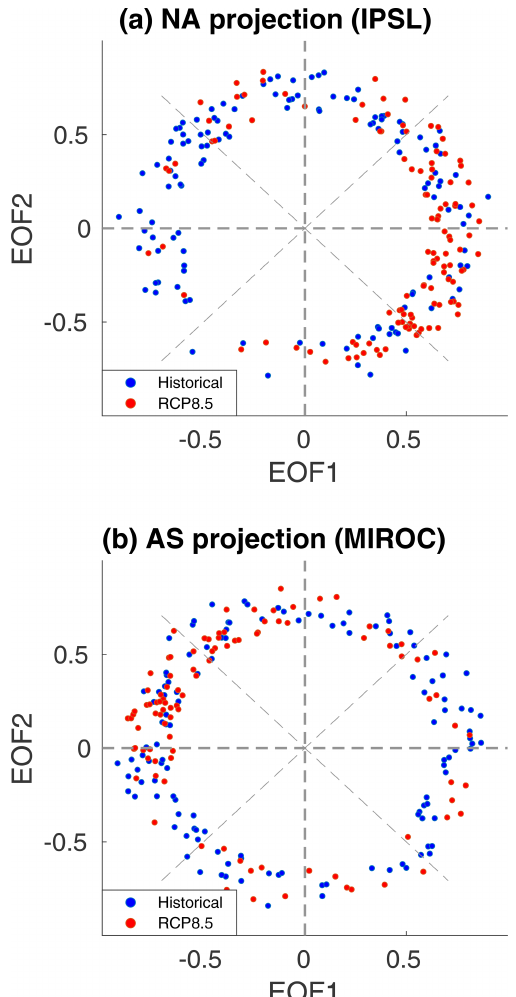
Figure 5. Examples of the monthly phase space. Projection of 300hPa monthly DJF V anomalies onto regional EOFs in two ensemble members: IPSL-CM5A-MR in the NA region (a) and MIROC-ESM-CHEM in the AS region (b) . Blue (red) dots are his- torical 1900–2005 (RCP8.5 2006–2099) monthly deviations from a 1900–1930 climatology. For clarity, only strongly projected months were